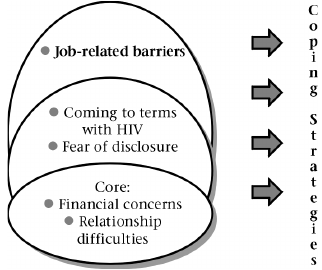
Figure 3: Integrated view of the